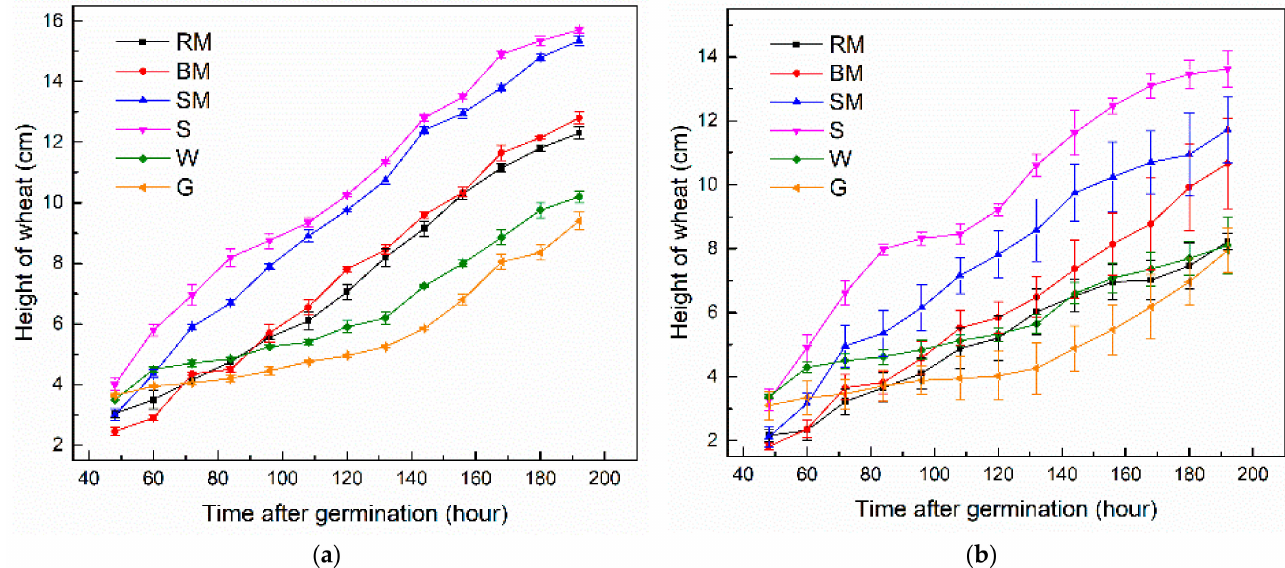
Figure 10. Height of wheats grown in biochar prepared using TF. ( a ) The top two highest plants (numbered as H 1-2 ); ( b ) the other six plants except the top two (numbered as H 6 ). Values are presented as mean ±